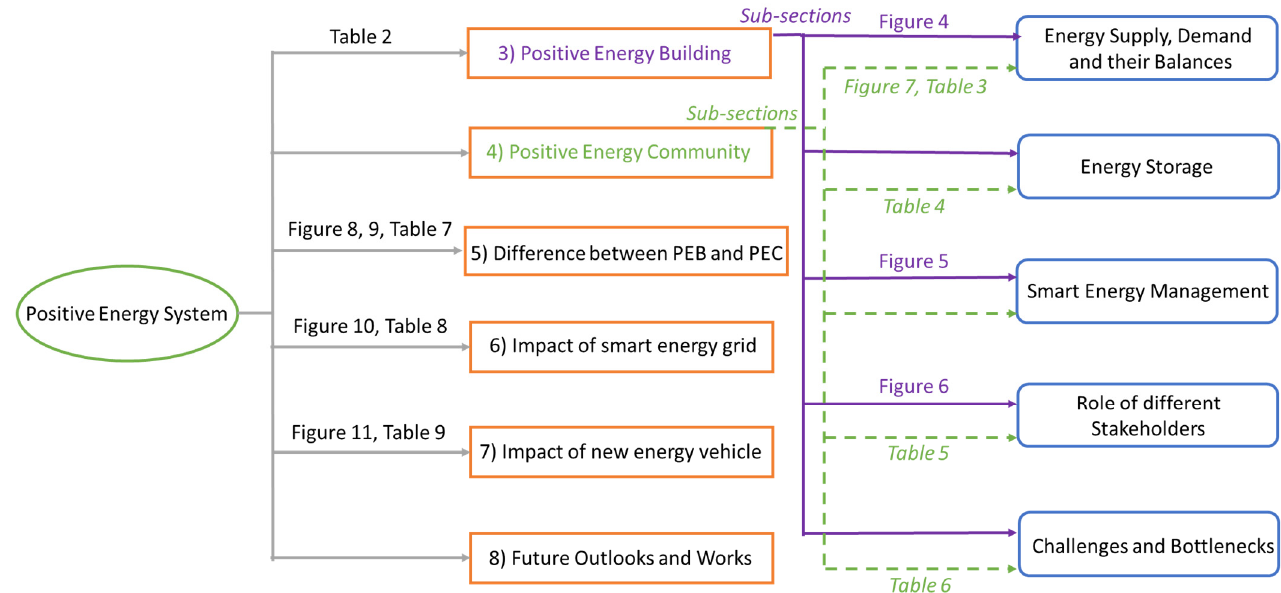
Figure 3. Outline of the review on positive energy building and